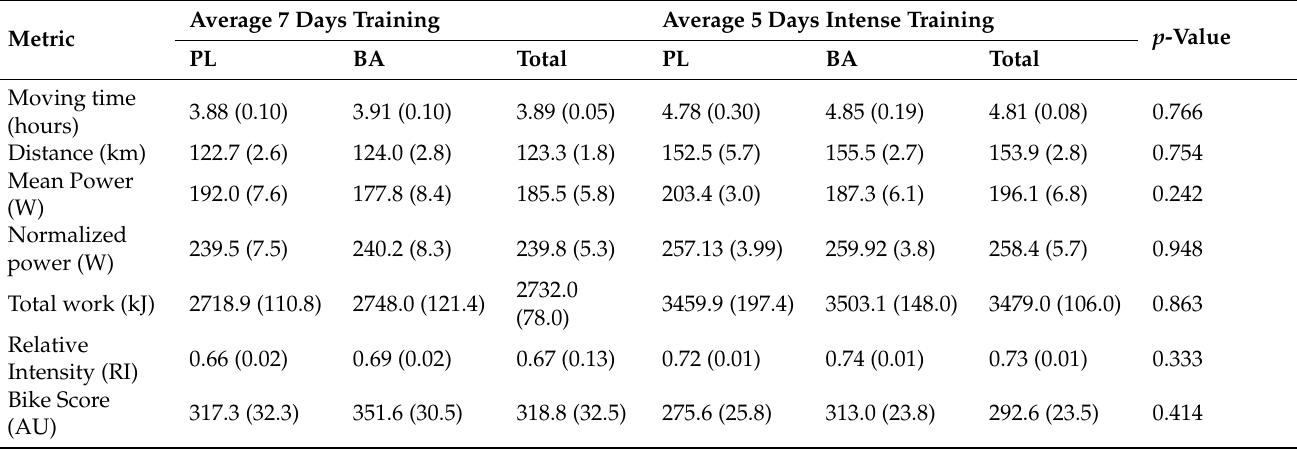
Table 4. Descriptive analysis of the mean daily load of all workouts during the one-week training camp and the mean of the 5 training days excluding regenerative workouts.